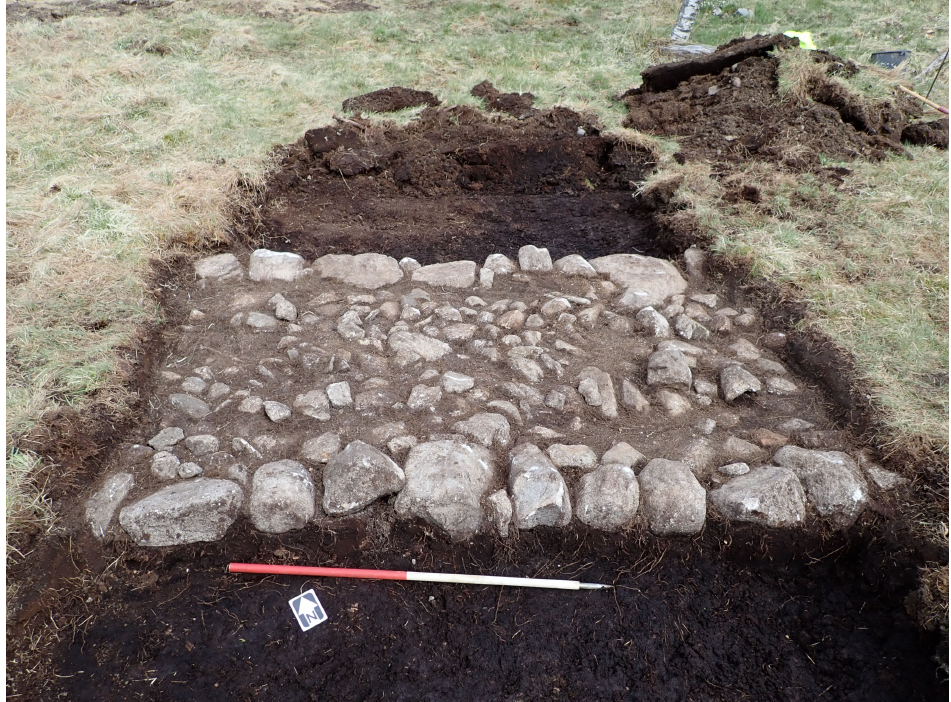
Figure 2. Excavation trench from Gausdal clearly showing the stone-set road remains in the mire. Image: Emma Norbakk, Agder